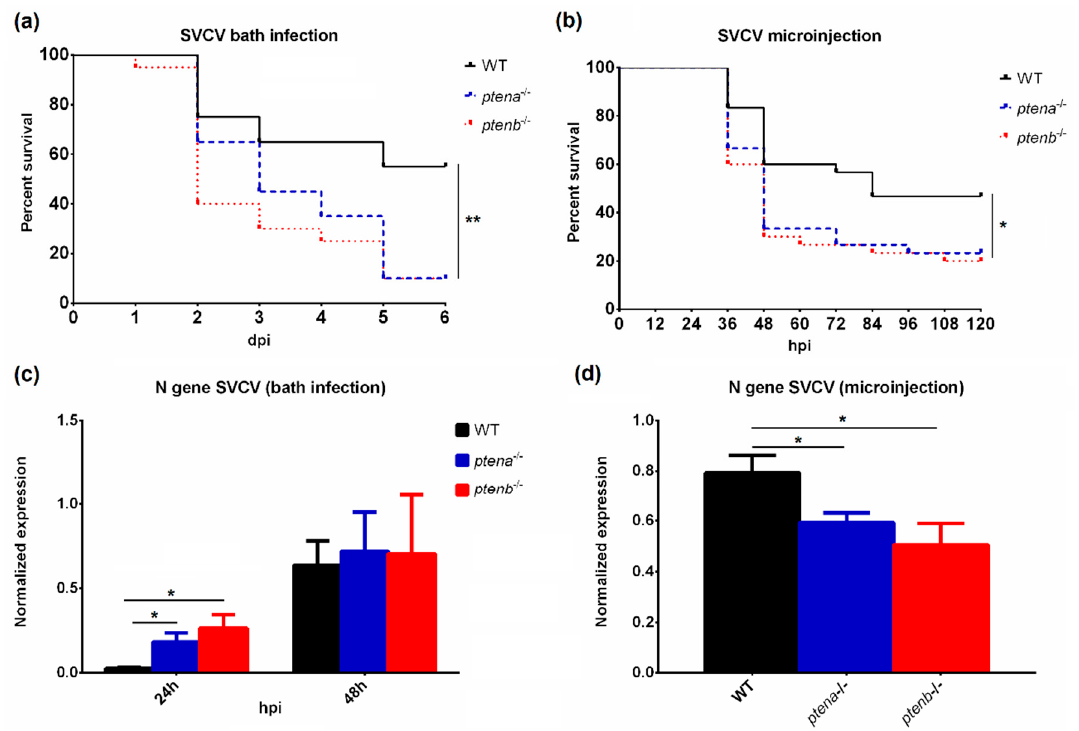
Figure 2. Effects of SVCV infection in wild-type and pten -mutant zebrafish larvae. Kaplan–Meier survival curves of the different zebrafish lines after SVCV challenge by bath infection ( a ) or microinjection into the duct of Cuvier ( b ). The statistically significant differences were determined with a log-rank (Mantel–Cox) test. The replication of the SVCV was analyzed by qPCR of the N gene at 24 h and 48 h after the bath challenge ( c ) and 24 h after the microinjection infection ( d ). The graphs represent the means ± SEMs of 3 and 5 biological replicates, respectively. In all the graphs, significant differences are displayed as ** (0.001 < p < 0.01) or * (0.01 < p < 0.05).